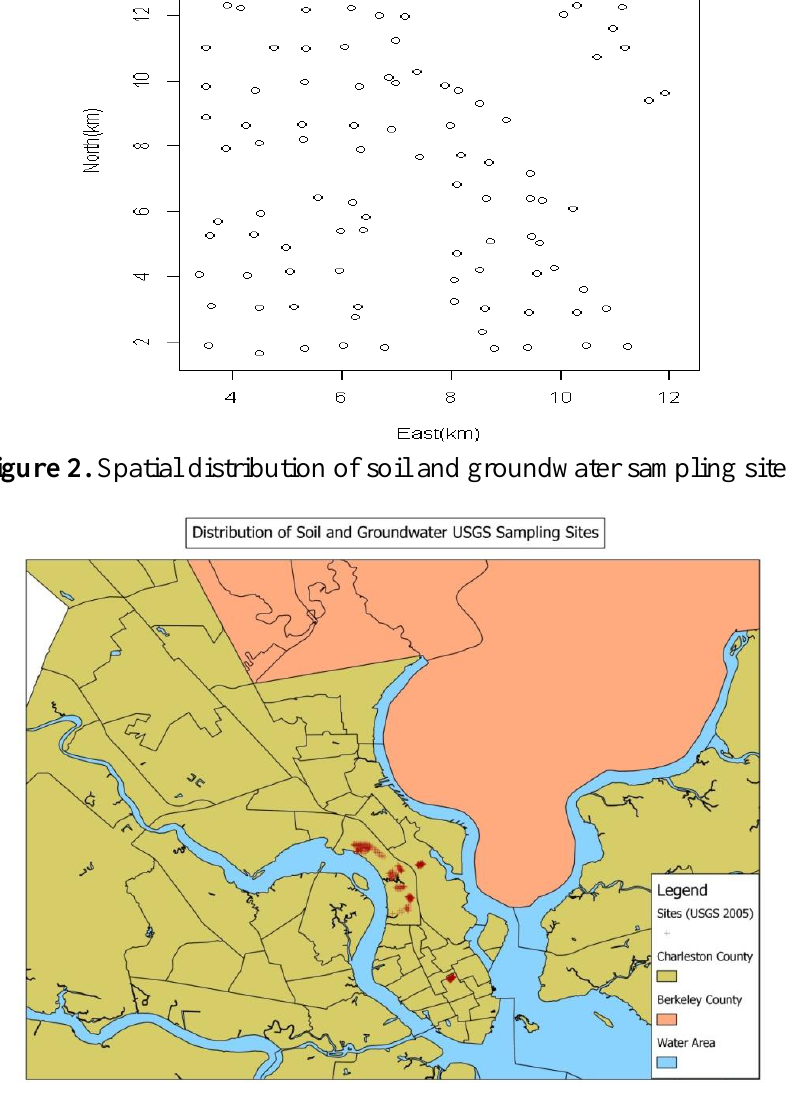
Figure 3. Histograms of address distances to soil mercury sampling sites for first, last and longest